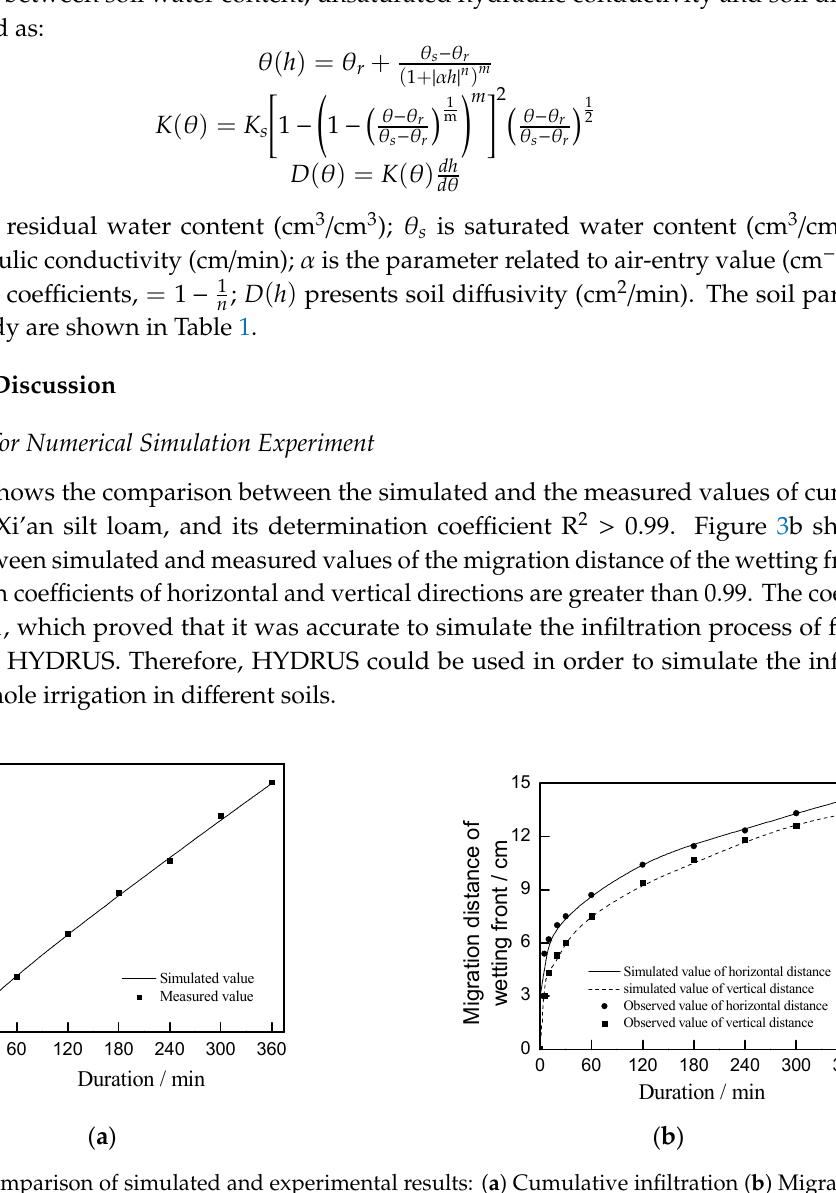
Figure 3. Comparison of simulated and experimental results: ( a ) Cumulative infiltration ( b ) Migration distance of the wetting front.